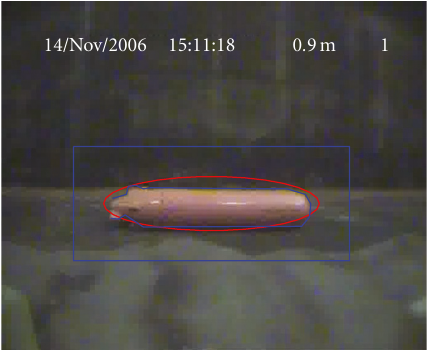
Figure 8: Segmentation of a mine in basin without water. C good = 0 . 96 and C false = 0 . 02.